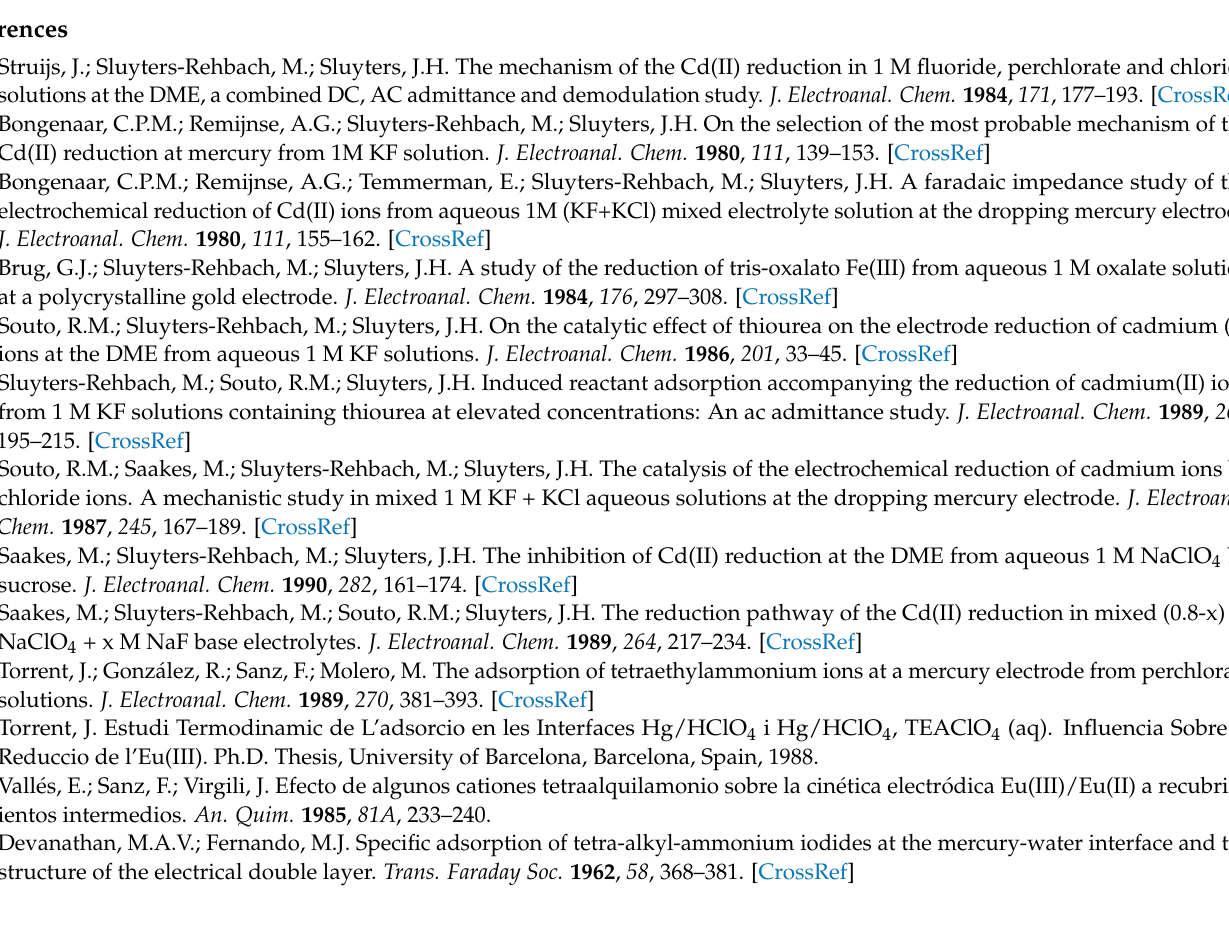
Figure S2: Plot of the double-layer capacitance Cdl vs. E at different TEA concentrations. TEA concentrations (mM): 0 (orange), 0.75 (grey), 2 (yellow), 5 (blue), 10 (green). Figure S3: Coverage θ vs. (E − Φ 2 ) at different TEA concentrations (mM): 0.75 (orange), 2 (grey), 5 (yellow), 10